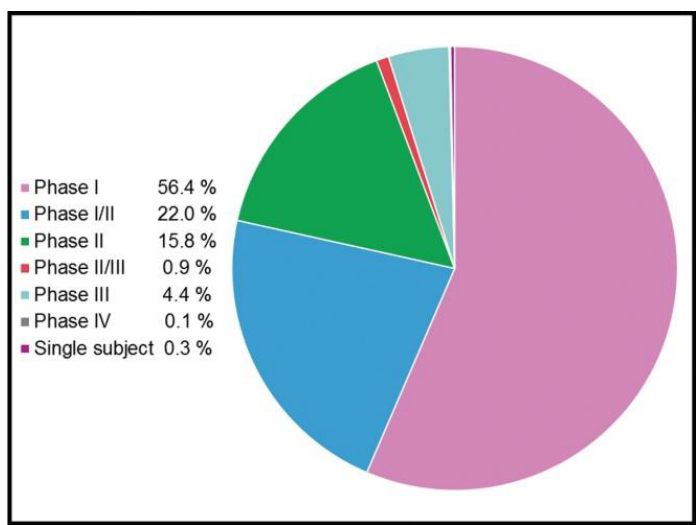
Figure 3. Clinical phases of 3180 ongoing trials based on gene therapy (adapted from http://www.genetherapynet.com/clinical-trials.html; accessed 1 June 2021; gene therapy clinical trial